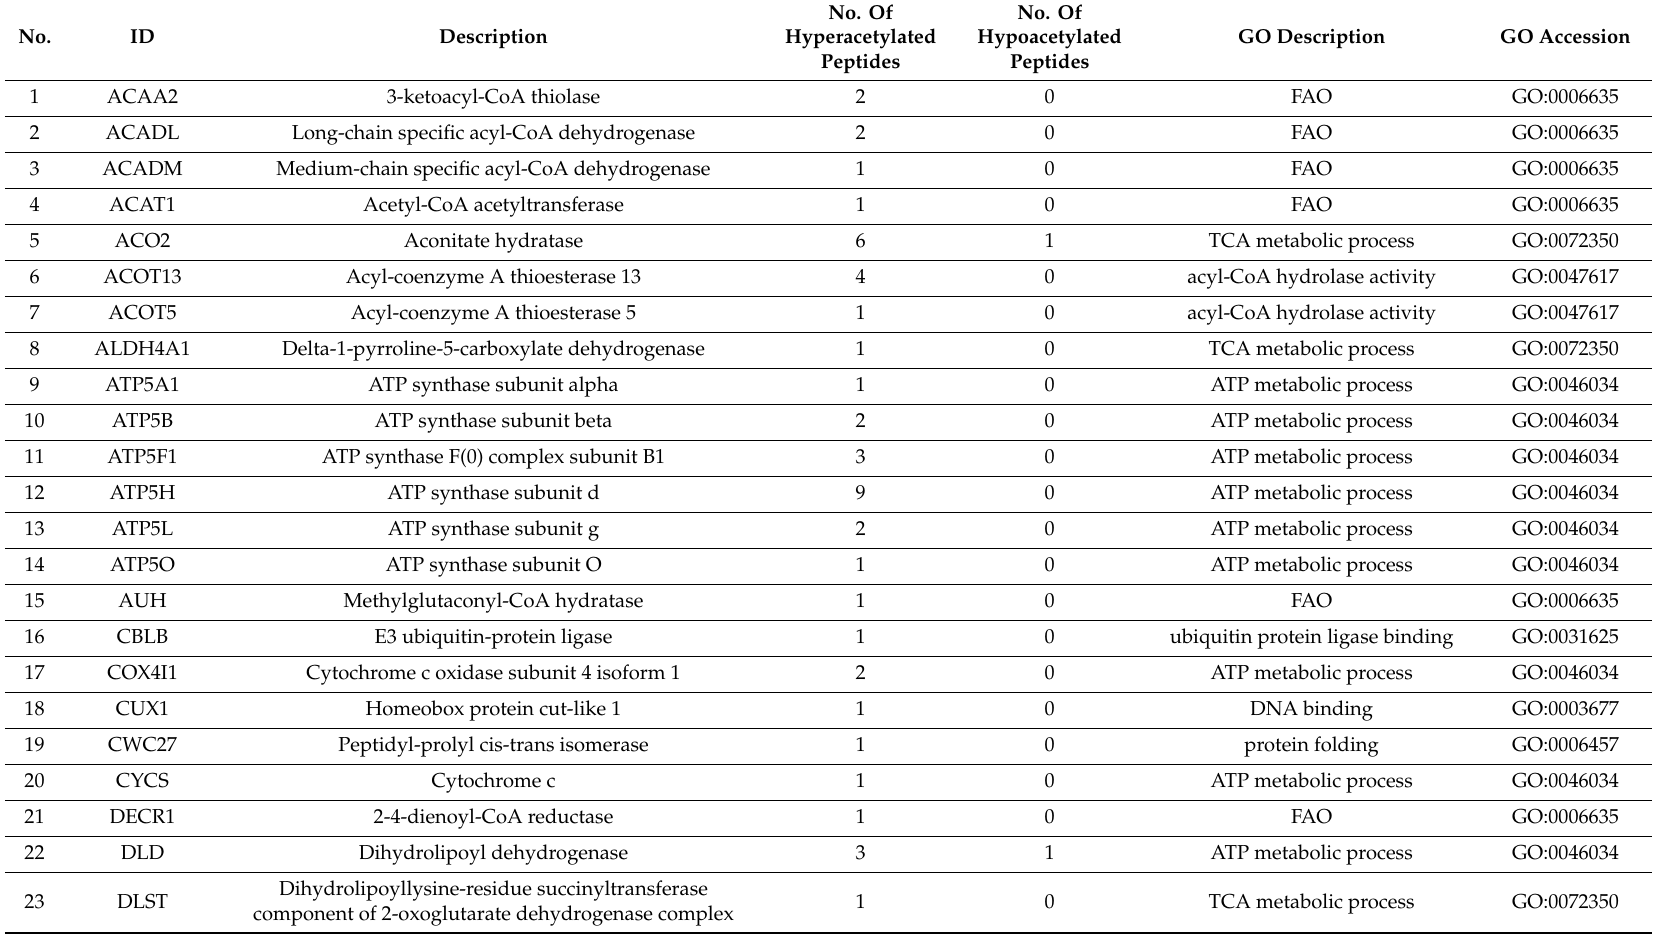
Table 1. List of significantly changed acetylated mitochondrial proteins following irradiation ( p < 0.05). The number of acetylated peptides, Gene Ontology (GO) description and GO Accession are shown for each acetylated